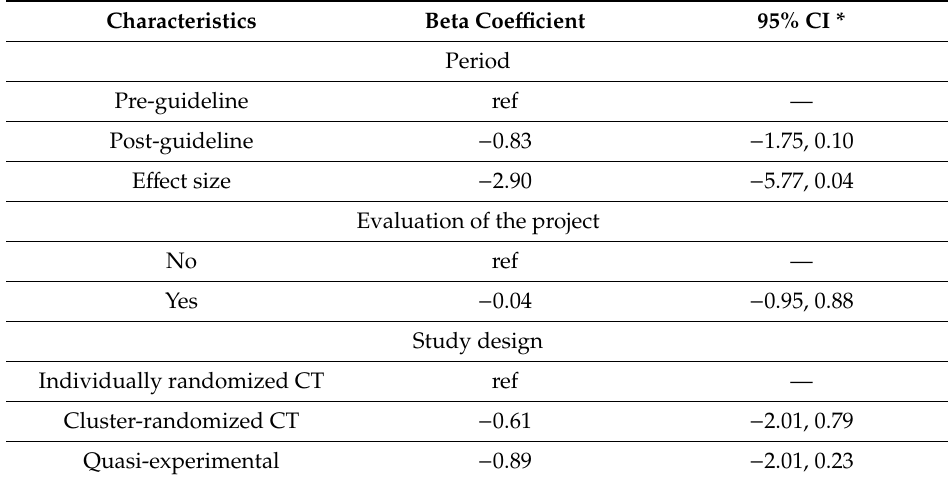
Table 3. Relationship between the study characteristics and the total reporting